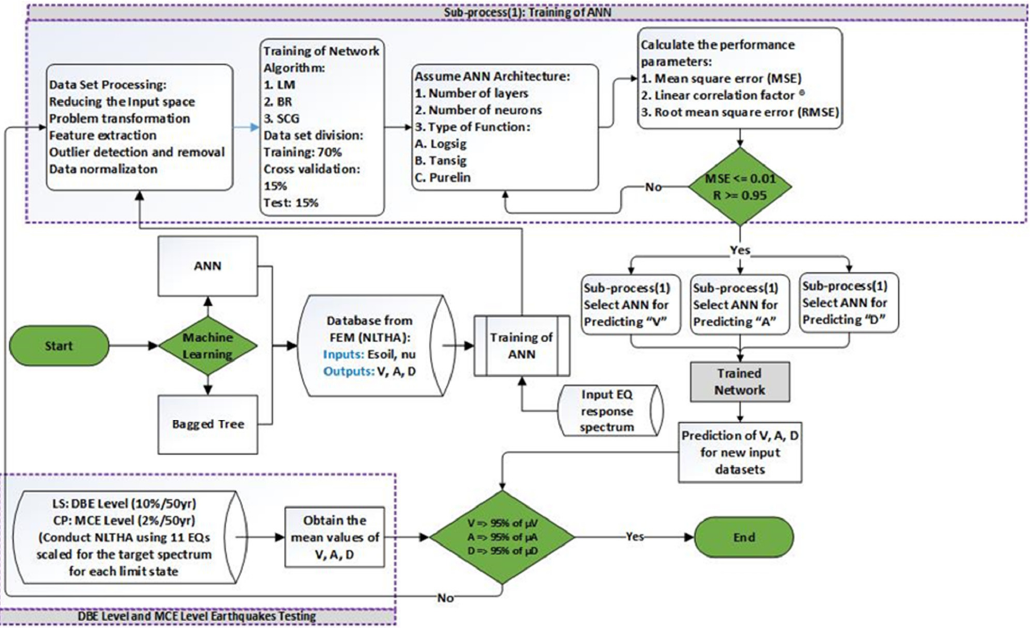
Figure 5. Flow chart of procedure adopted for machine learning.